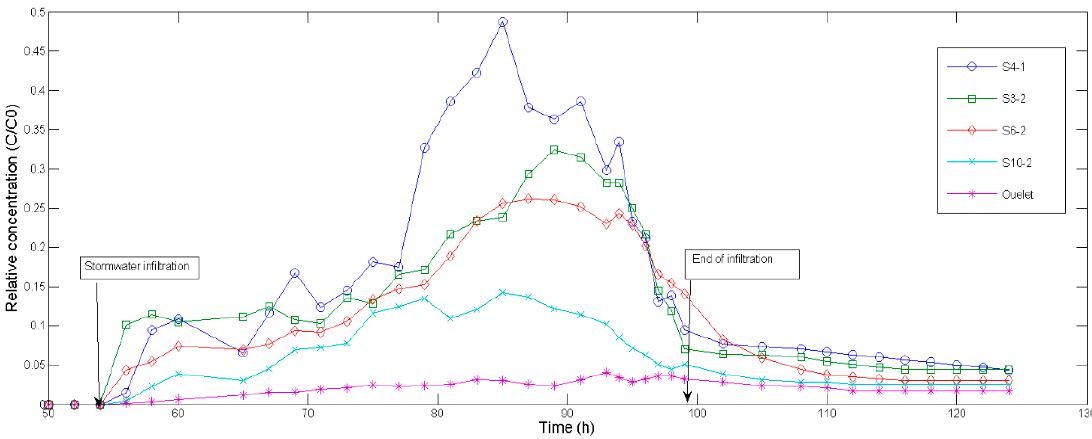
Figure 8. Observed breakthrough curves of the suspended particles (SP) for different sampling ports.